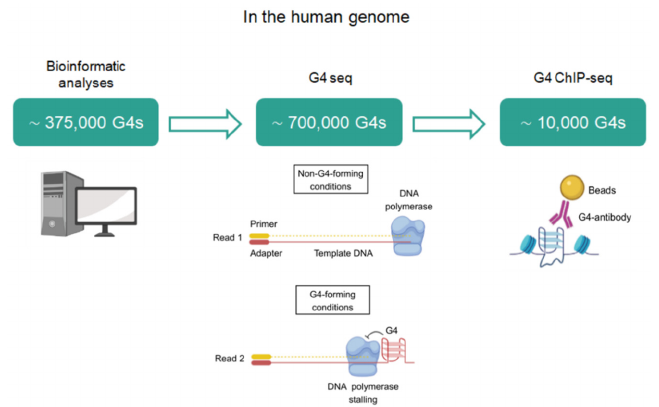
Figure 2. Quantity of G4s identified in the human genome with different methodologies. Bioinformatic analyses search for the consensus G4 sequence. G4 ‐ seq maps G4s by DNA polymerase stalling followed by high ‐ throughput sequencing. In G4 ‐ seq, fragmented genomic DNA is sequenced twice: first in non ‐ G4 ‐ stabilizing conditions (Read 1) to provide a reference, and then in G4 ‐ stabilizing conditions (Read 2) to identify the positions of G4 ‐ dependent DNA polymerase stalling. G4 ChIP ‐ seq maps DNA G4s using chromatin immunoprecipitation with G4 ‐ specific antibodies and next ‐ generation sequencing.